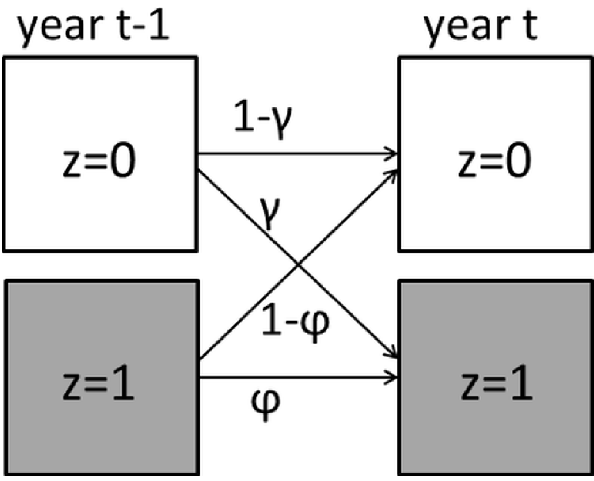
Figure 1. Dynamic site-occupancy model. z is true occupancy (0 or 1) of a site, Q is local persistence probability, 1- Q is local extinction probability, c is local colonisation probability and 1- c is the probability that the site stays unoccupied.